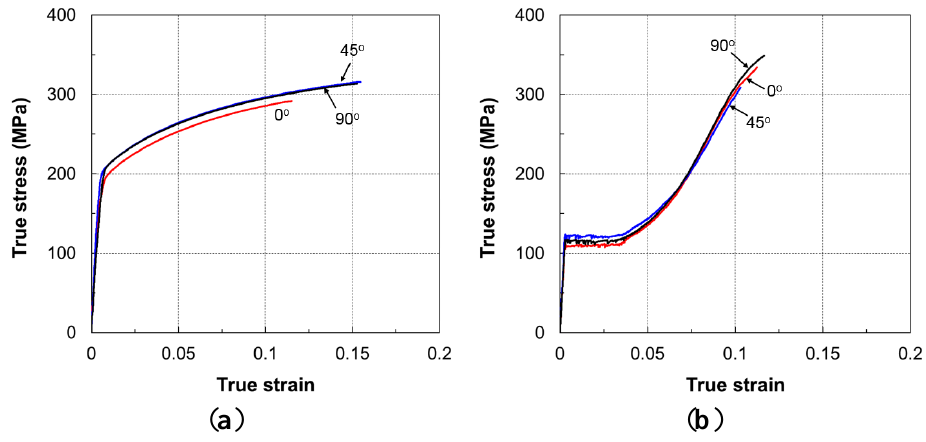
Figure 7. Flow curves of different specimen orientations at room temperature: ( a ) tension loading and ( b ) compression loading.